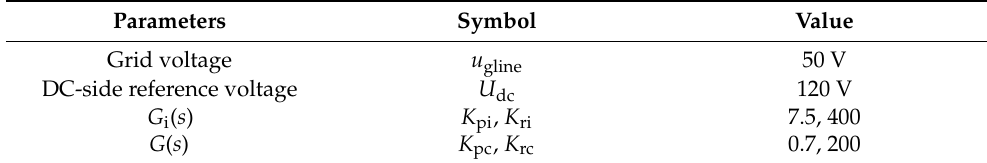
Table 2. Some parameters of the experimental setup.